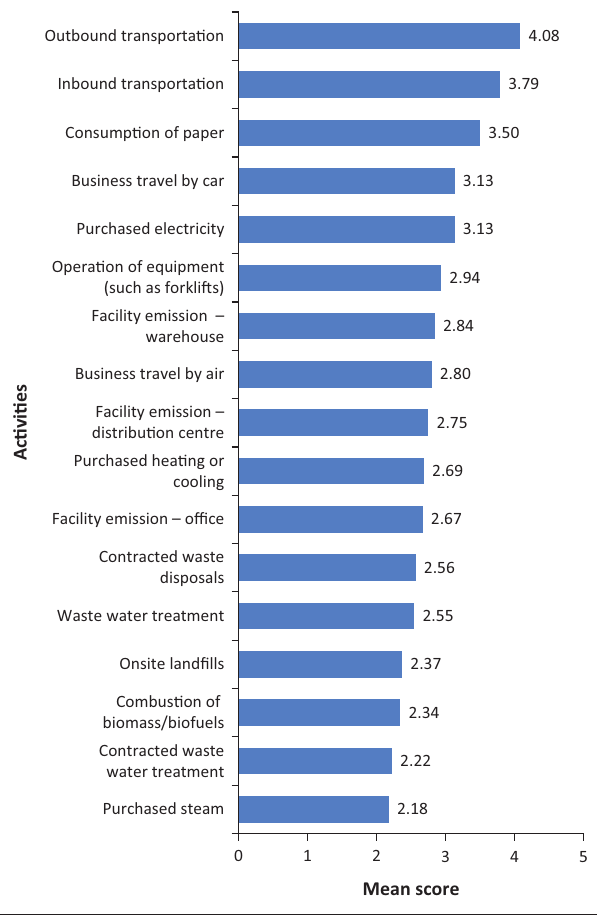
FIGURE 1: Activities contributing to greenhouse gas emission (mean scores).